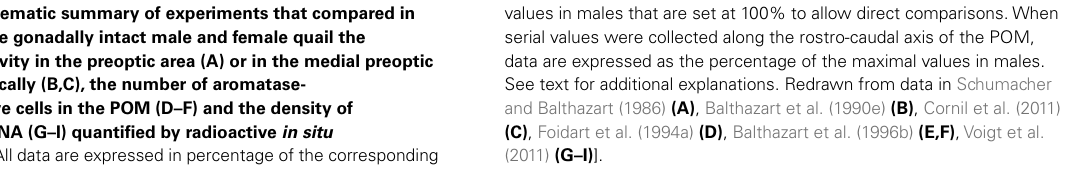
values in males that are set at 100% to allow direct comparisons.When serial values were collected along the rostro-caudal axis of the POM, data are expressed as the percentage of the maximal values in males. See text for additional explanations. Redrawn from data in Schumacher and Balthazart (1986) (A) , Balthazart et al. (1990e) (B) , Cornil et al. (2011) (C) , Foidart et al. (1994a) (D) , Balthazart et al. (1996b) (E,F) ,Voigt et al. (2011) (G–I)